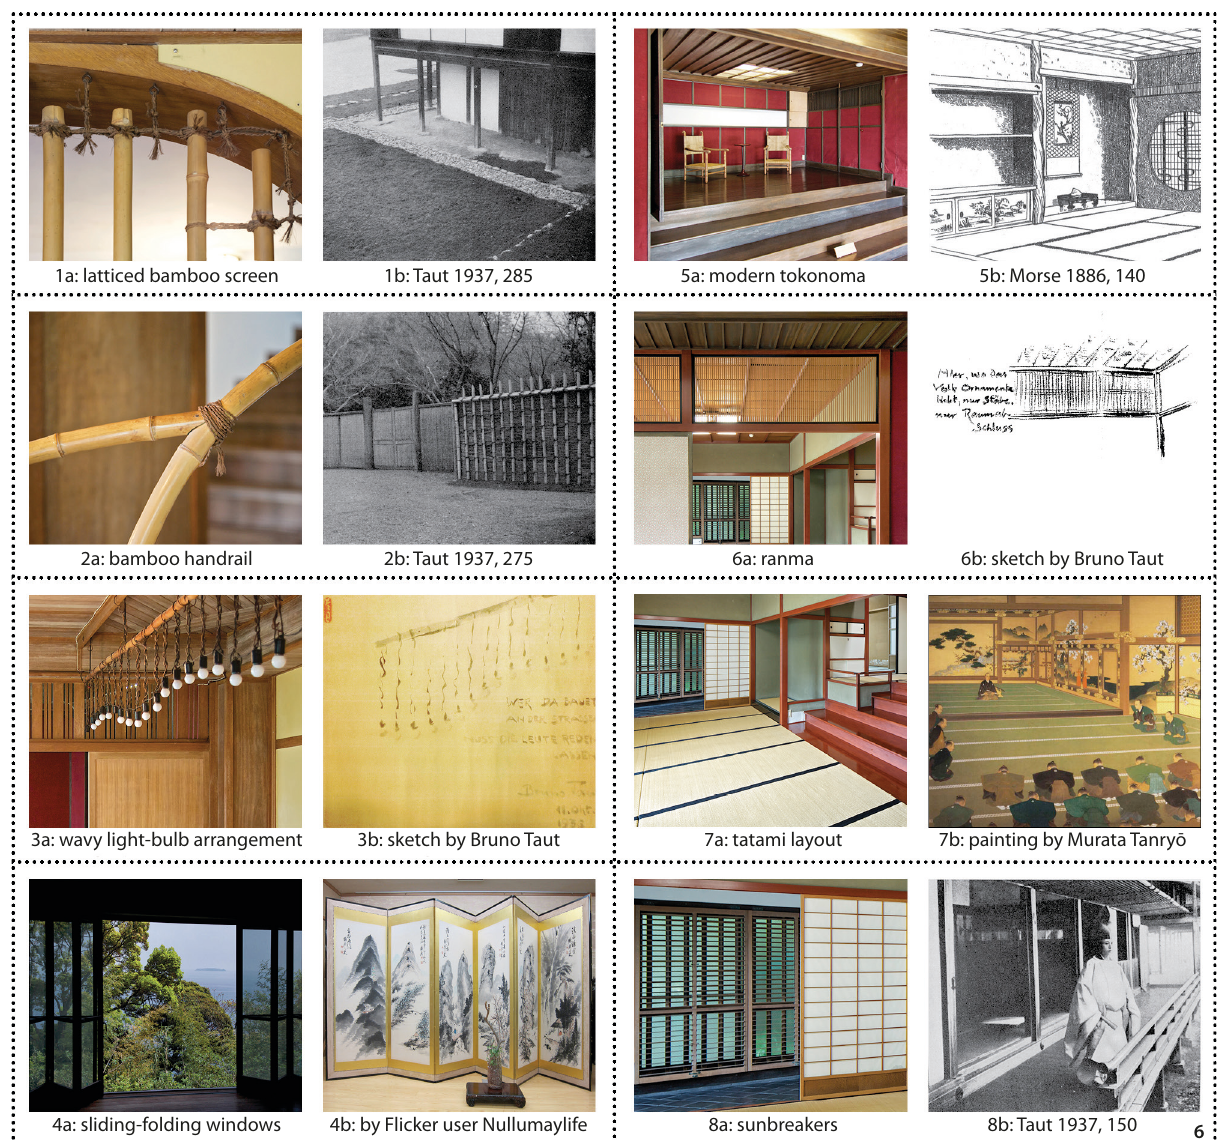
Figure 6 Graphical summary of Taut’s acts of translation throughout the building (Source: photographs of Hyuga Villa by Dave